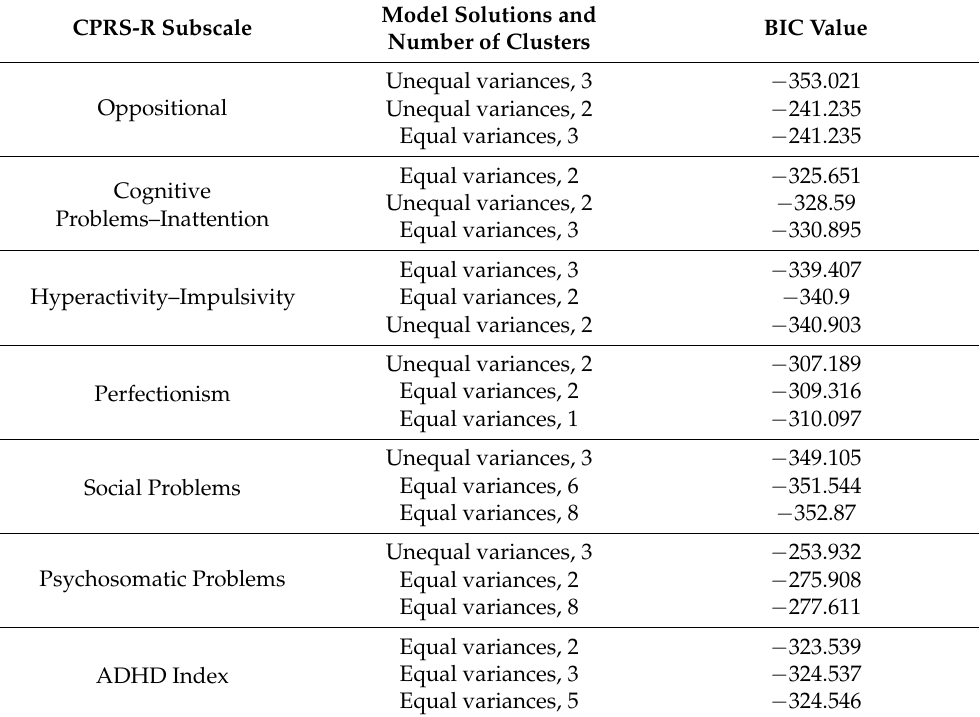
Table A1. Top three FGMMs based on the BIC criterion (clinical variables). The models that were selected as best are underlined.